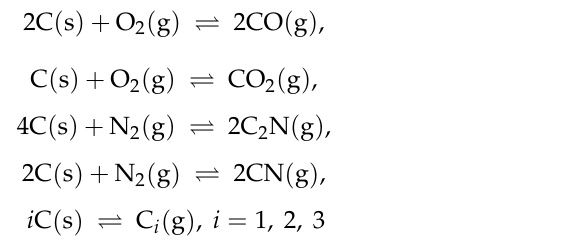
Figure 1. Schematic diagrams of ( a ) hypersonic flow around a bluff body; ( b ) heat transfer and ab- lation surface recession at the macro scale; ( c ) changes in the surface morphology of vertical fibers before and after ablation at the micro scale; and ( d ) changes in the surface morphology of inclined fibers before and after ablation at the micro scale.